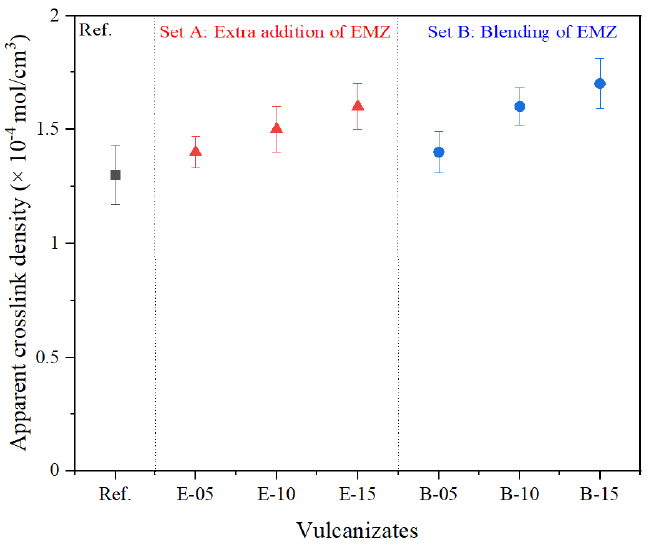
Figure 5. Effect of EMZ contents on the apparent crosslink density of silica - filled NR vulcanizates . EMZ was added via either extra addition (Set A) or blending (Set B)